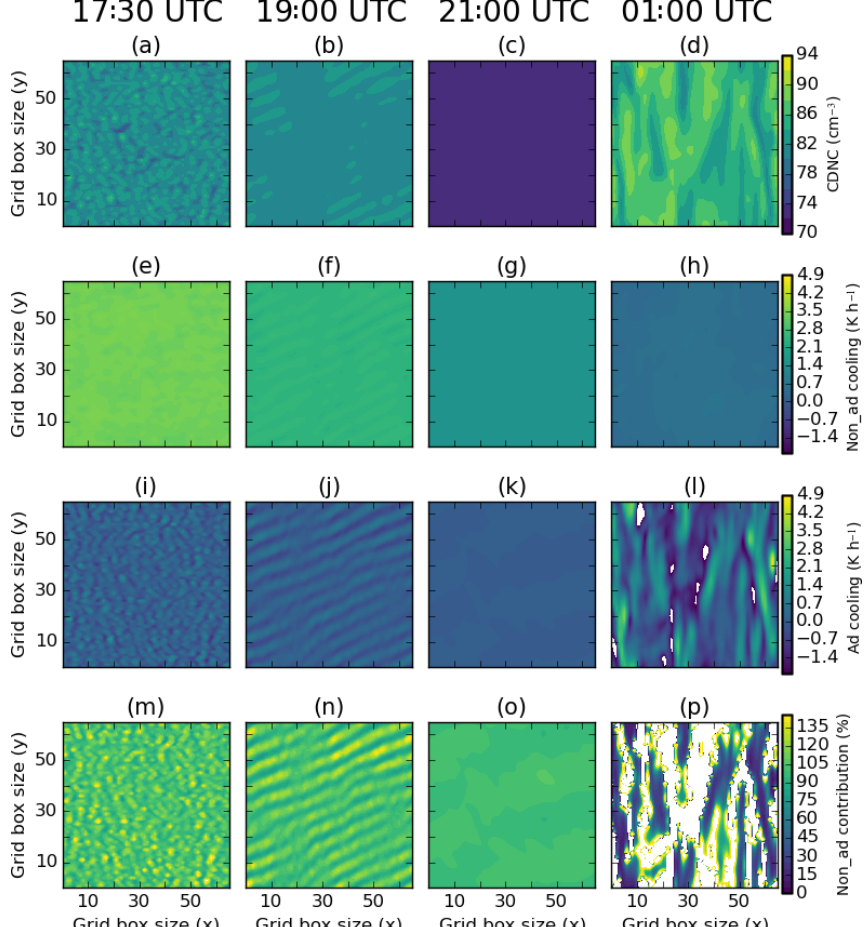
Figure 6. Horizontal slices made at z = 2m of FDNC (cm − 3 ) in T_SMOD at (a) 17:30, (b) 19:00, (c) 21:00 and (d) 01:00UTC. (e–h) Non-adiabatic cooling (Kh − 1 ); (i–l) adiabatic cooling (Kh − 1 ); (m–p) non-adiabatic cooling contribution (%). Note that for the cooling contribution, white masks out regions where the contribution is greater than 140